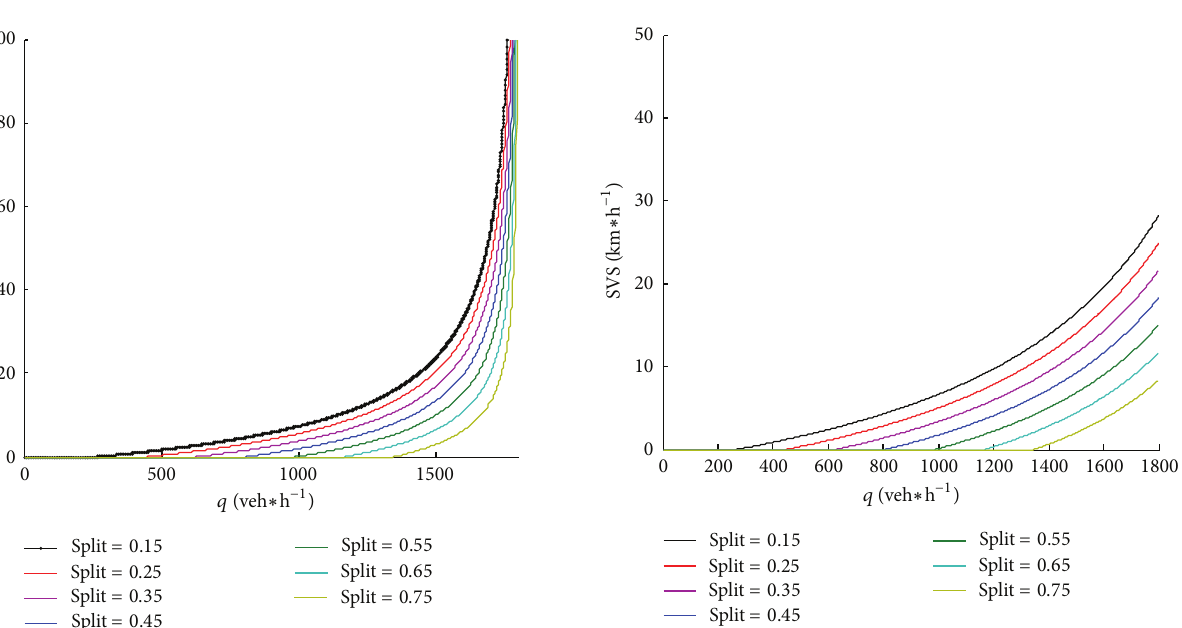
Figure 15: SVS versus arriving flow rate; 𝑘 𝑗 = 180 veh/km, 𝑞 𝑚 = 1800 veh/h.